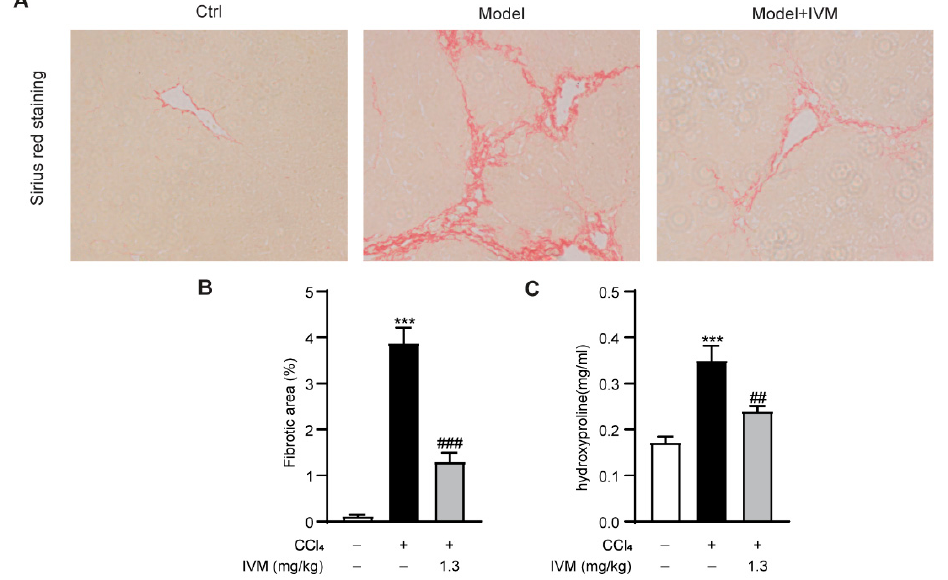
Figure 2. Ivermectin inhibited fibrosis in CCl 4 -treated mice: ( A ) Sirius red staining (original magnifi- cation, × 200) of liver tissues; ( B ) quantitation of fibrotic areas in the liver; ( C ) hydroxyproline levels in the liver. Data are expressed as means ± SEM ( n = 6–8/group). Note: *** p < 0.001 vs. control group, ## p < 0.01, ### p < 0.001 vs. CCl 4 -treated model